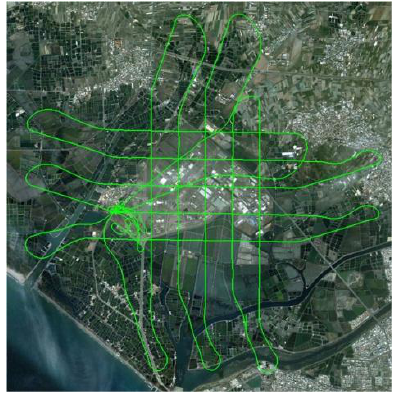
Figure 11 Trajectories of test